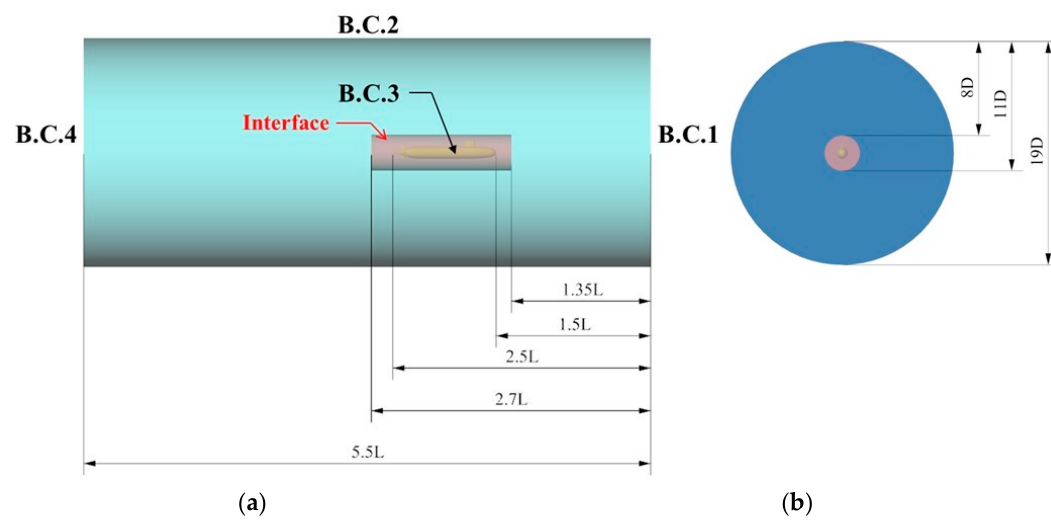
Figure 3. The computational fluid domain at ( a ) side view, and ( b ) front view, respectively.